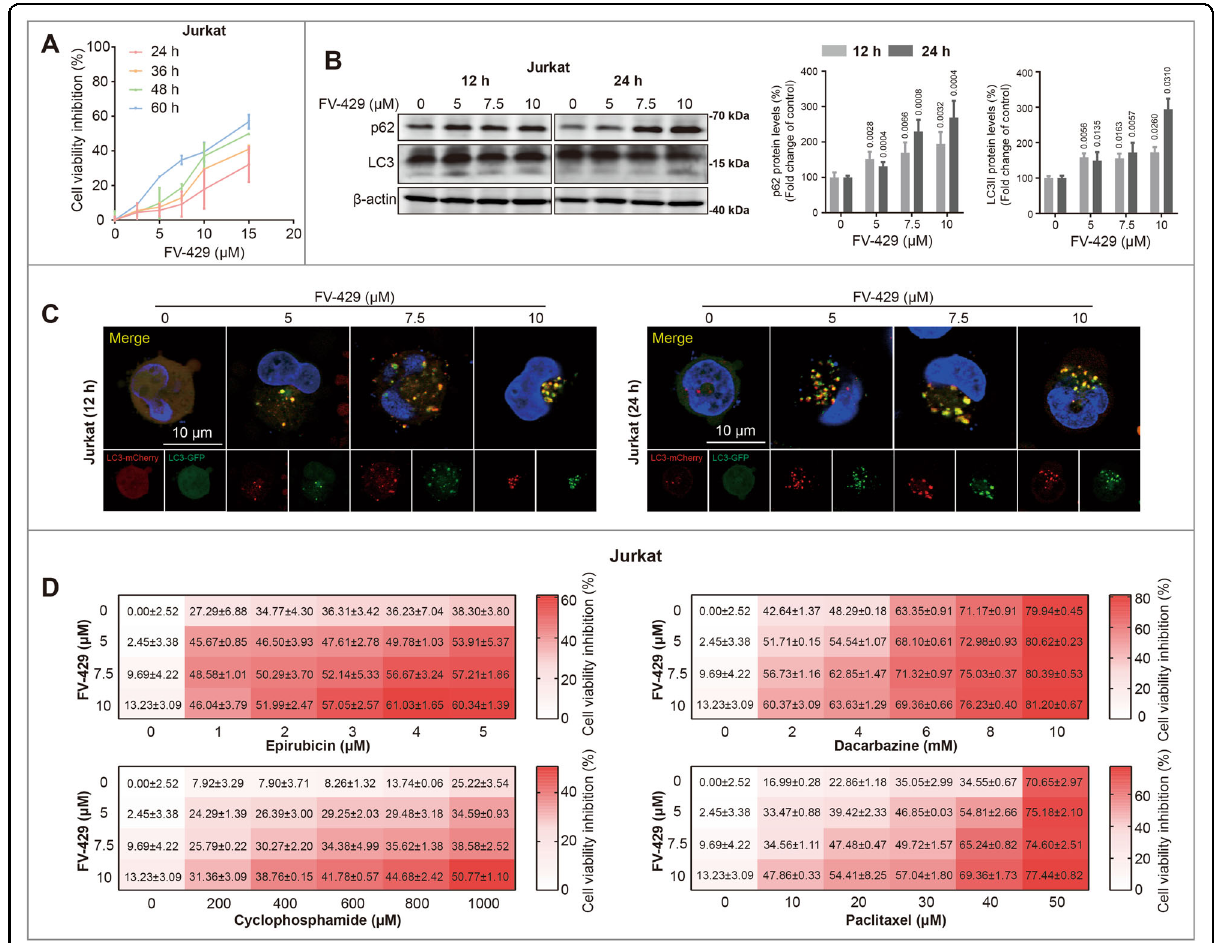
indicated times, and the cell viability inhibition was determined by CCK8 assay. B The Jurkat cells were treated with 0, 5, 7.5, and 10 μ M FV-429 for 12 and 24 h, the expression levels of p62 and LC3 were determined by western blot. β -actin used as loading control. The statistically signi fi cant differences with respect to 0 μ M FV-429 groups. C The Jurkat cells transfected with a plasmid encoding LC3-GFP-mcherry were treated with 0, 5, 7.5, and 10 μ M FV-429 for 12 and 24 h, and LC3II puncta count were calculated (scale bar: 10 μ m; total puncta in each group >200) (mean± s.e.m. for 3 independent experiments; p values are shown on the graph). D The Jurkat cells were pre-treated with 0, 5, 7.5, and 10 μ M FV-429 for 12 h, and then treated with chemotherapy drugs (Epirubicin, Dacarbazine, Cyclophosphamide, and Paclitaxel) for 24 h. The cell viability inhibition rates (mean ± s.e.m.) were determined by CCK8 assay and shown in heat